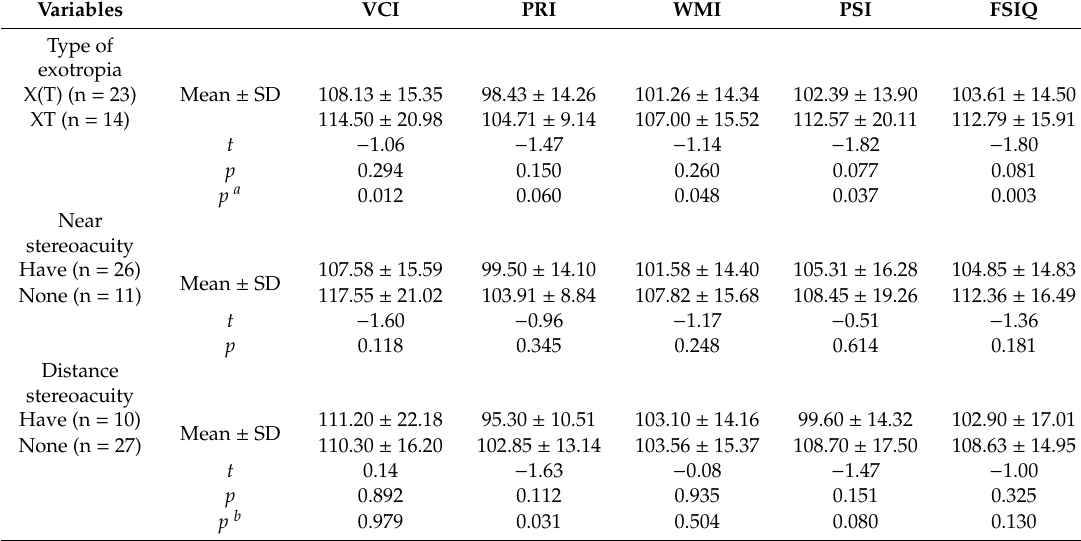
Table 4. Subgroup analysis of the WISC-IV index scores stratified by di ff erent types of exotropia, near stereoacuity, and distance stereo acuity.